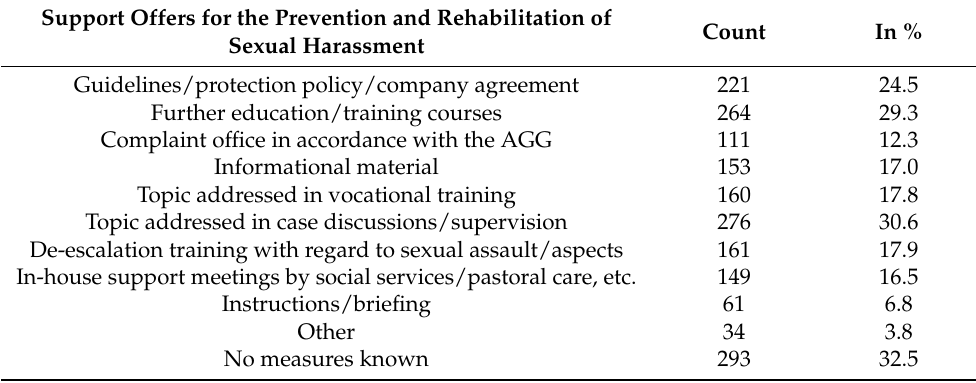
Table 5. Awareness of support offers for the prevention and rehabilitation of sexual harassment in social and healthcare